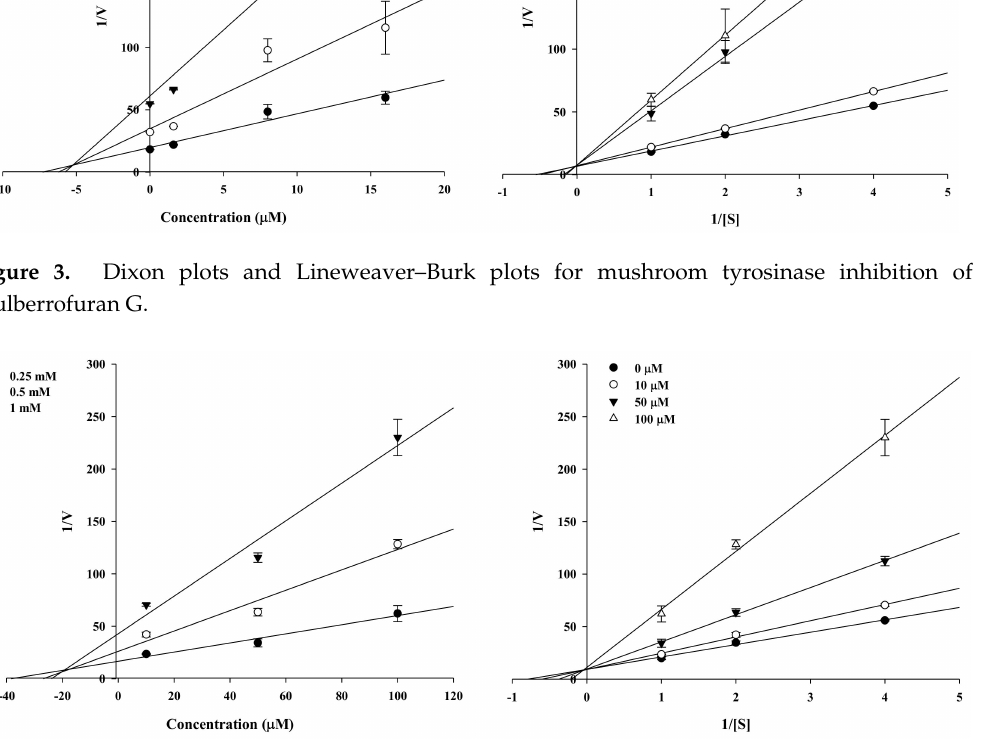
Figure 4. Dixon plots and Lineweaver–Burk plots for mushroom tyrosinase inhibition of kuwanon